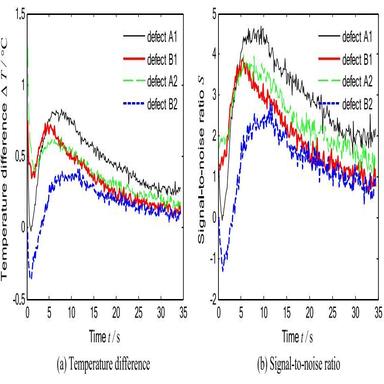
Experimental informative parameter evolutions of sample B.